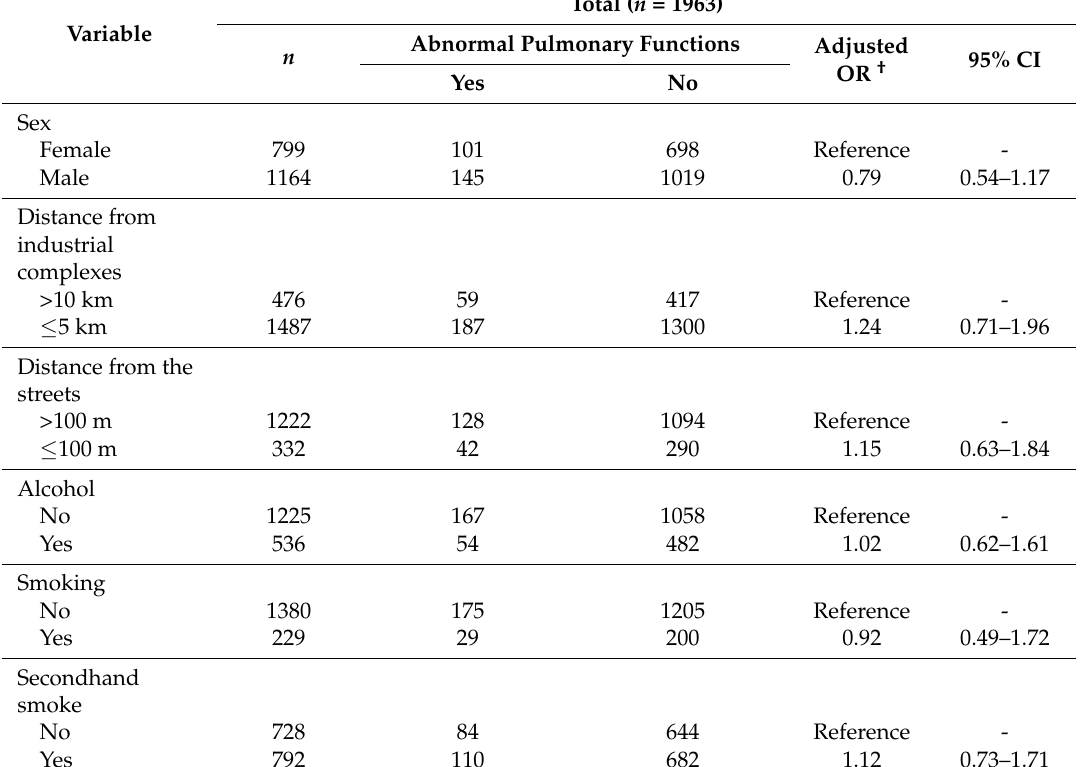
Table 5. Prevalence odds ratios (OR) of abnormal pulmonary functions of residents in both cities calculated by logistic regression